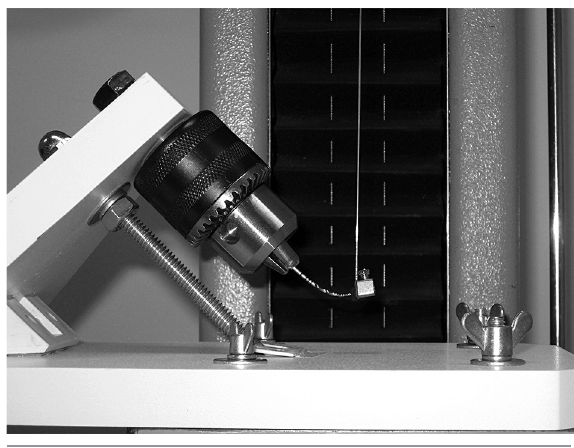
Figure 1. The 45° bending test